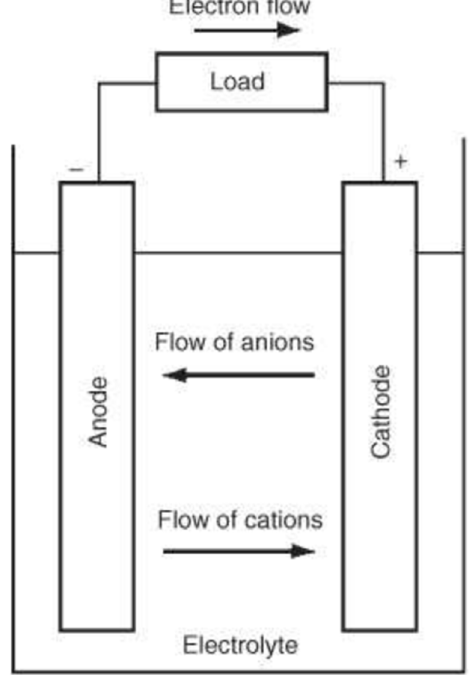
Figure 1. Discharge process of a cell [26].